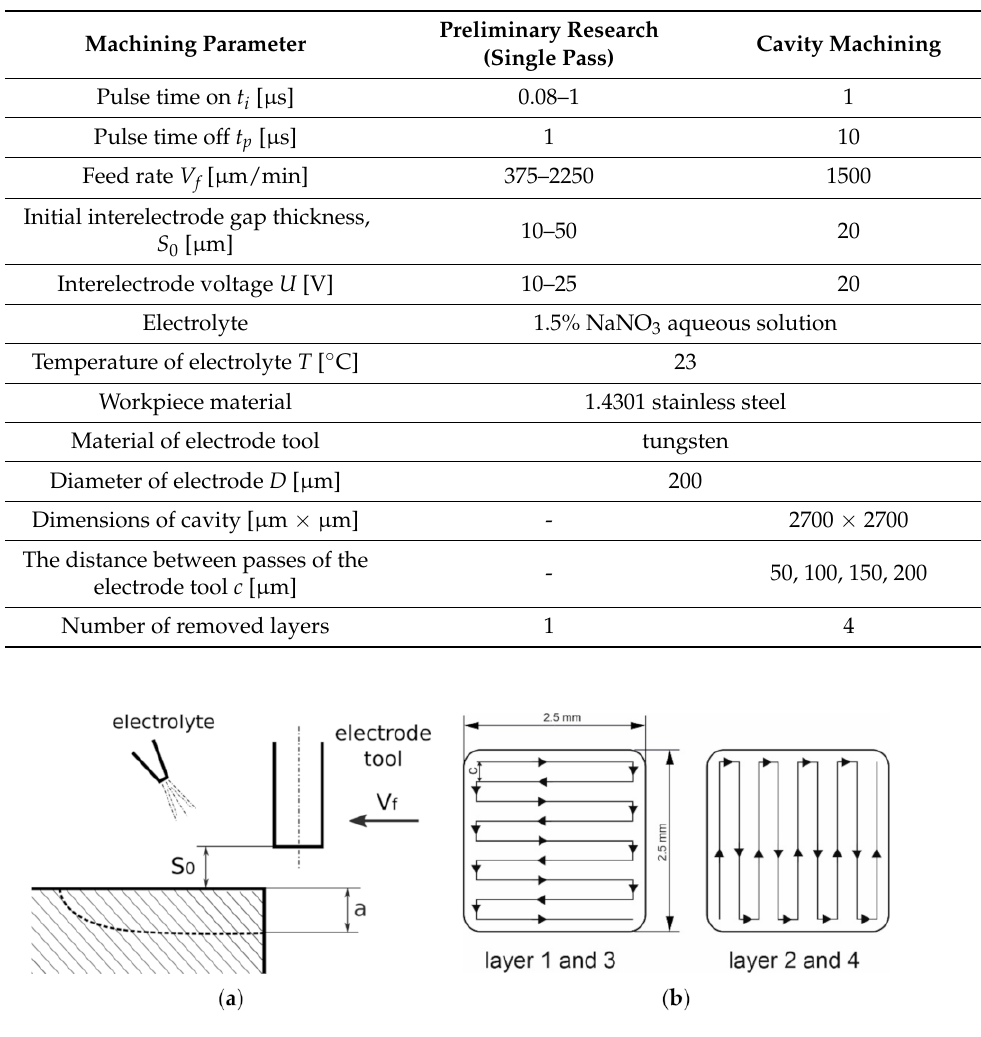
Figure 11. Scheme of research realization ( a ) and a trajectory of the electrode tool applied in the research ( b ). v f —tool feed, S 0 —size of initial interelectrode gap, a —thickness of the removed material, c —the distance between passes of the electrode tool; during machining of cavity, the electrode-tool moved on the same